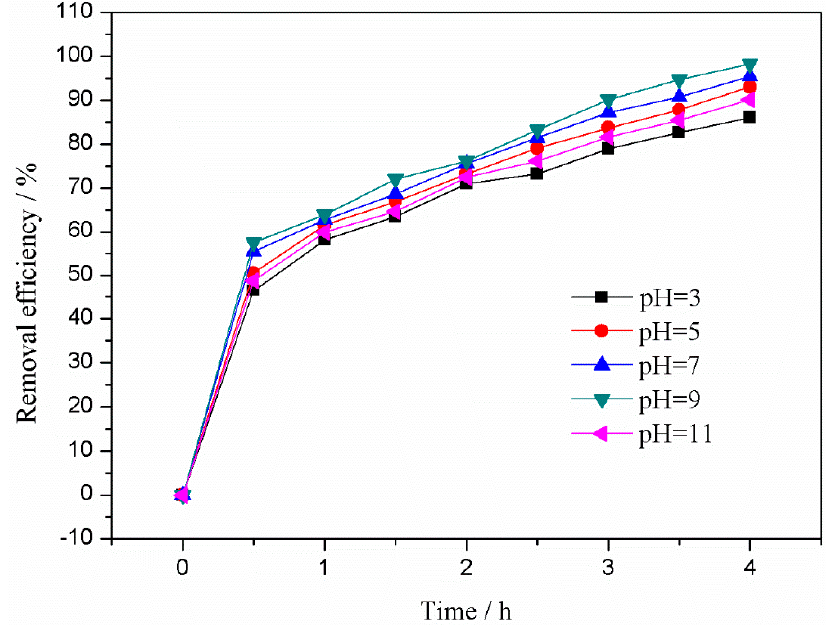
Figure 10. Chloride ion removal efficiency as a function of initial pH value.